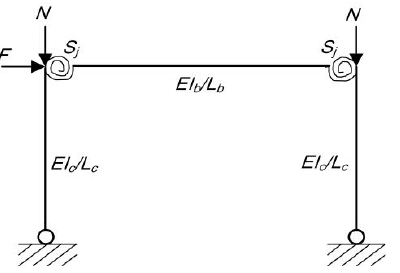
Figure 4. Simple frame with semi-rigid beam-to-column joints.